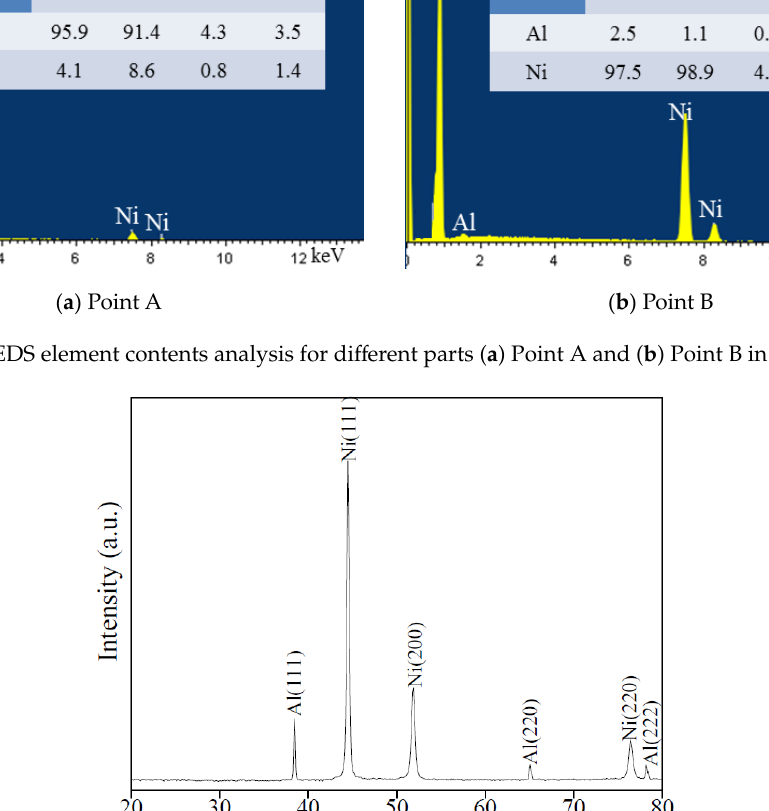
Figure 3. XRD spectrum of Ni80Al20 alloy powder.